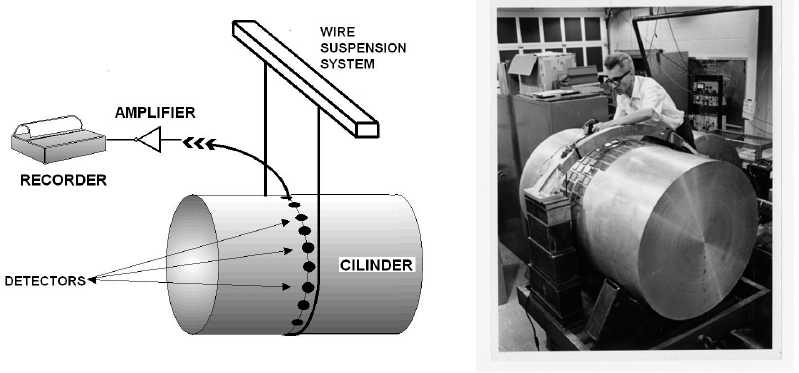
Figure 4. Sketch of Weber’s cylinder detector and photo of Joseph Weber at the antenna.